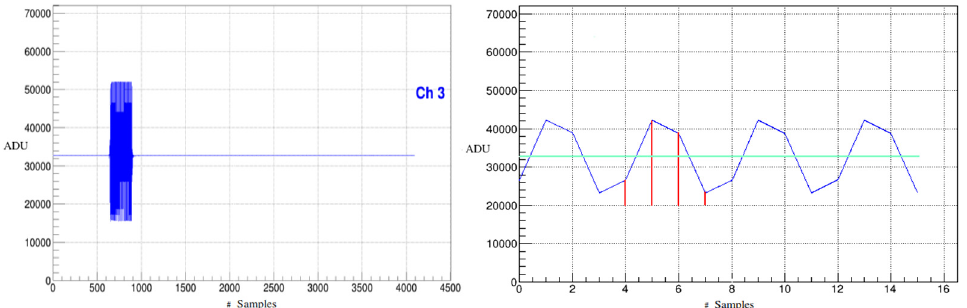
Figure 14. Generated pulsed RF signal centered at 750 MHz ( left plot ) and sampled IF signal at 125 MSPS ( right plot ).